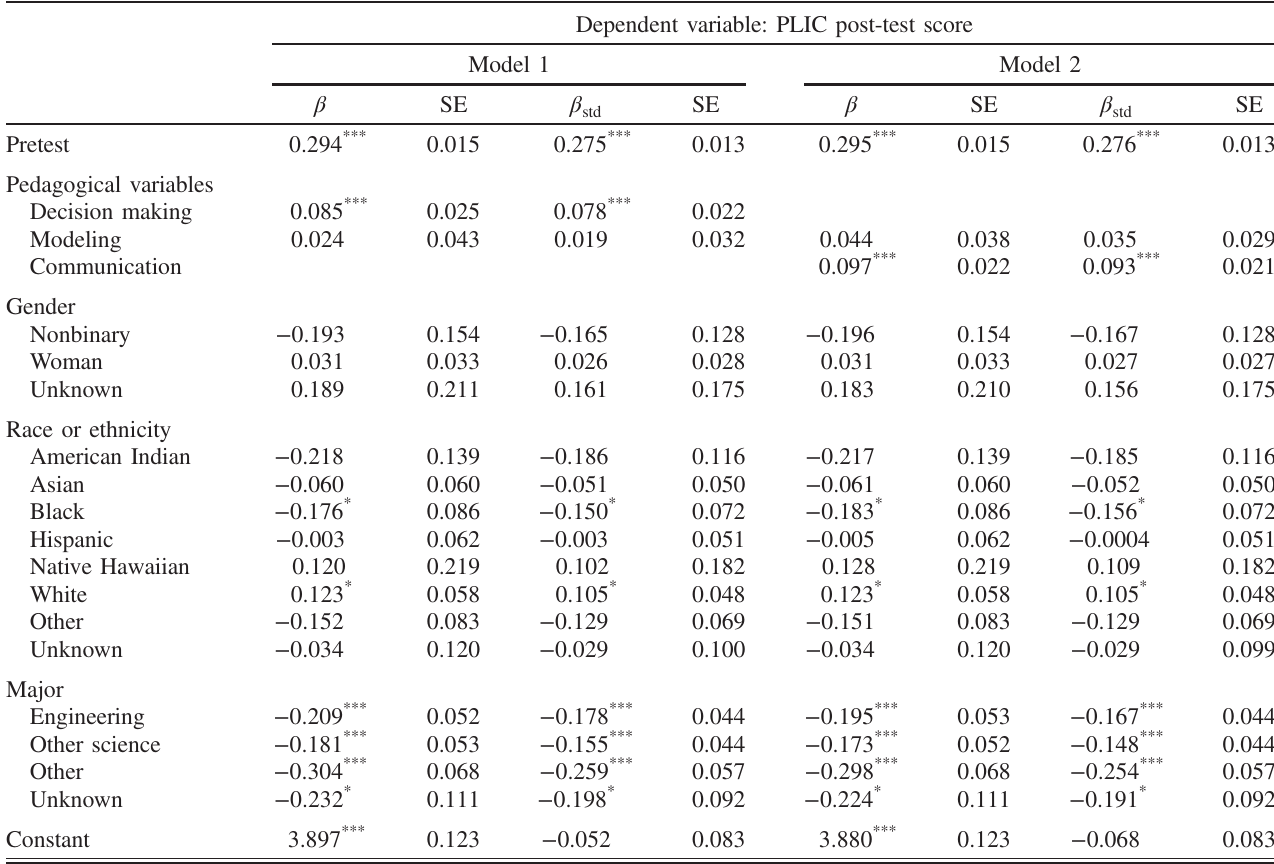
TABLE VII. Two-level linear mixed models of PLIC post-test scores including pedagogical and demographic variables with institution as a random intercept. Standardized coefficients represent effects with pretest and post-test scores grand mean centered. For nominal variables, effects are estimated relative to the reference level, which can be inferred by the level of the variable that is not shown in the table. The percent variance explained by the fixed effects alone is approximately 10% for both models. The percent variance explained by the fixed and random effects together is approximately 16% for model 1 and approximately 17% for model